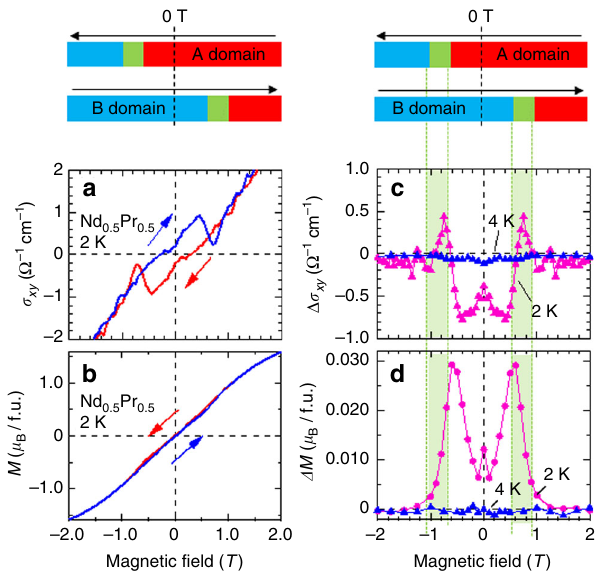
Fig. 3 Hall conductivity and magnetization for (Nd 0.5 Pr 0.5 ) 2 Ir 2 O 7 . Magnetic fi eld dependence of a Hall conductivity and b magnetization for a magnetic fi eld along [111] direction at 2 K. The blue (red) lines are Hall conductivity and magnetization on fi eld-increasing ( fi eld-decreasing) process. The difference of c Hall conductivity and d magnetization between fi eld- increasing and fi eld-decreasing process. The magenta and blue denote 2 K (> T N ) and 4 K (< T N ), respectively. The top pictures show the domain states in each process. The red bars indicate A domain, blue ones are B domain, and green ones denote the domain fl ipping